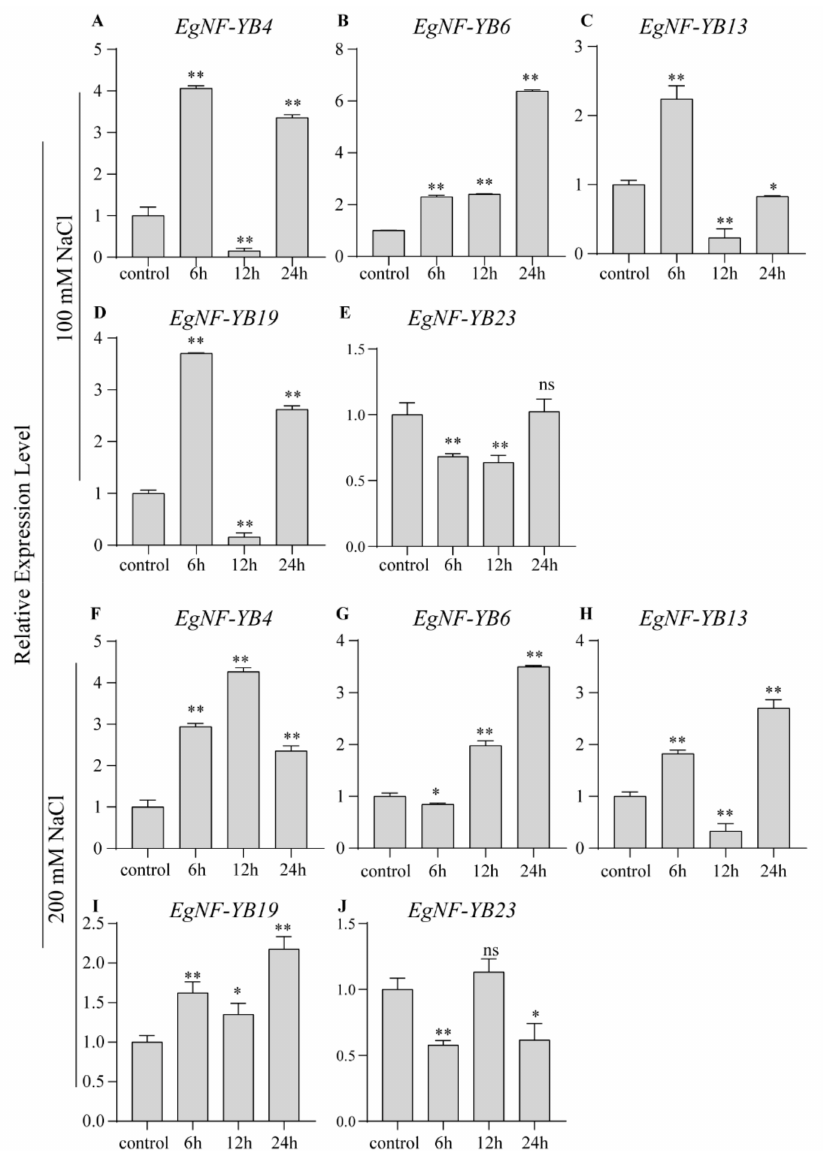
Figure 7. qRT-PCR expression analysis of five selected EgNF-YBs genes under salt treatment. ( A – E ) low salt (100 mM NaCl); ( F – J ) high salt (200 mM NaCl). The processing time of each group was control (no treatment), 6 h, 12 h and 24 h. Mean expression value was calculated from three independent replicates. Error bars indicate standard deviation. Data are presented as mean + standard deviation (SD). Asterisks on top of the bars indicate statistically significant differences between the stress and counterpart controls (* p < 0.05, ** p < 0.01 and ns >